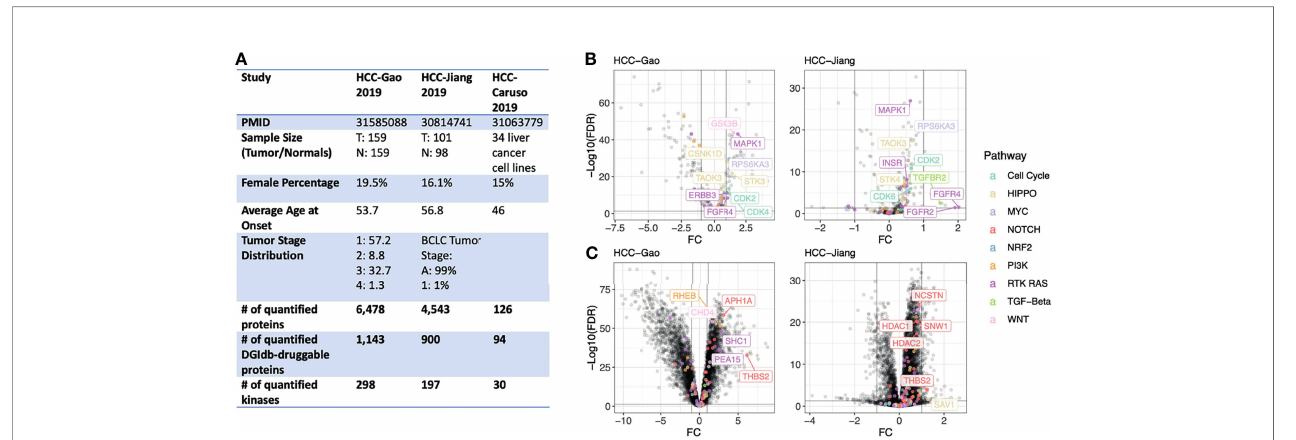
FIGURE 1 | Study overview and differentially-expressed proteins in primary HCC tumors. (A) Overview of the proteogenomic datasets of human liver cancer cohorts and human liver cell lines analyzed in this study. (B) Volcano plots showing differentially-expressed kinase proteins between HCC tumor and normal liver samples in both the HCC-Gao and HCC-Jiang cohorts. The top differentially-expressed kinases from onco-signaling pathways are further labeled with text. (C) Volcano plots showing differentially-expressed non-kinase proteins between HCC tumor and normal liver samples in both the HCC-Gao and HCC-Jiang cohorts. The top differentially-expressed non-kinases from onco-signaling pathways are further labeled with